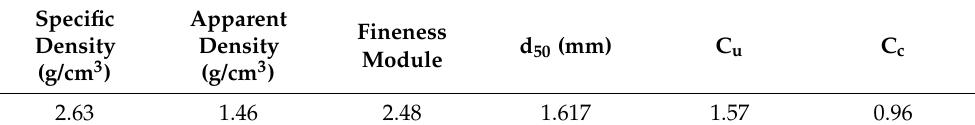
Table 3. Physical properties of